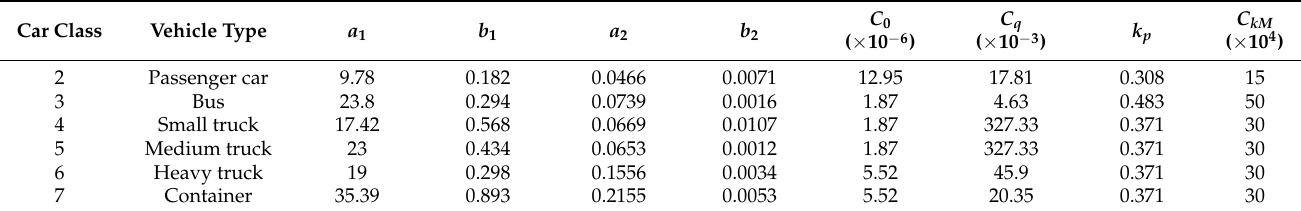
Table 15. Parameters for calculating fuel consumption, wheel consumption and material